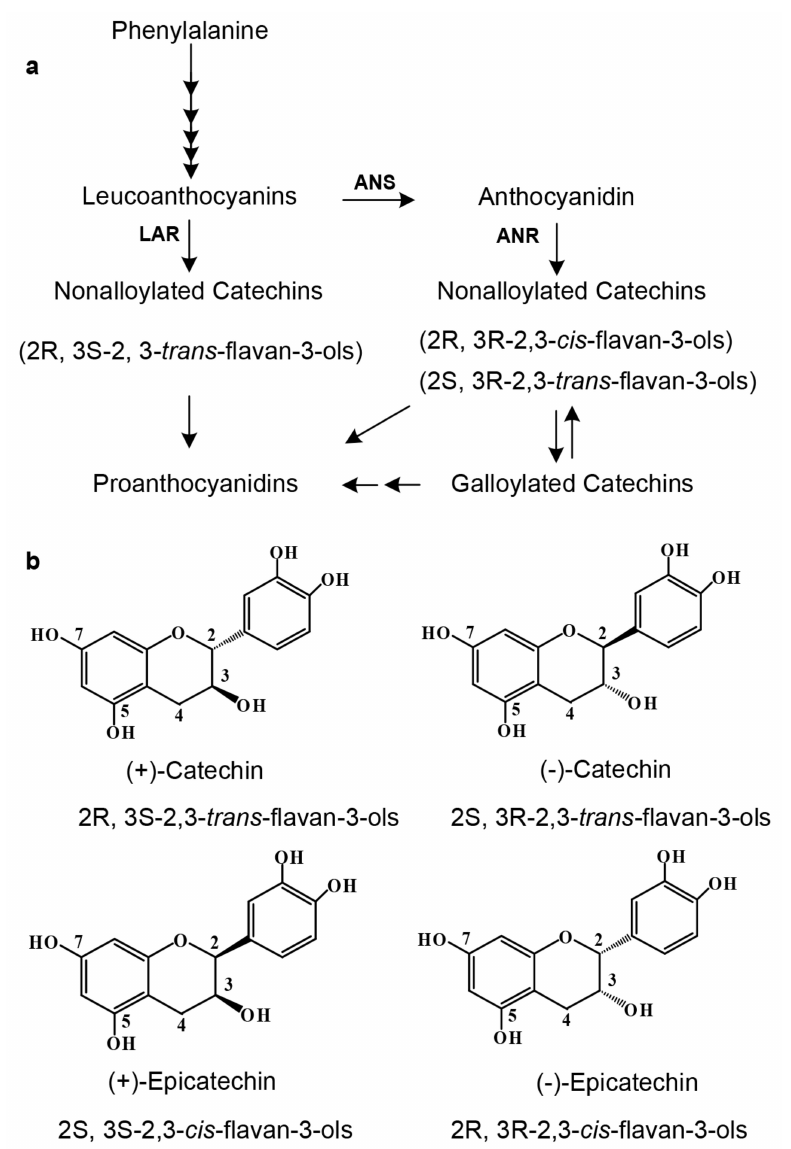
Figure 1. Biosynthetic pathways of flavan-3-ols and proanthocyanidins starting from leucoanthocyanidins in tea plant. ( a ) the ANR pathway to 2 R ,3 R -2,3- cis -flavan-3-ols and 2 S ,3 R -2,3- trans -flavan-3-ols via anthocyanidins and the LAR pathway to 2 R ,3 S -2,3- trans -flavan-3-ols; ( b ) four stereo structures of catechin. LAR, leucoanthocyanidin reductase; ANS, anthocyanidin synthase; ANR, anthocyanidin